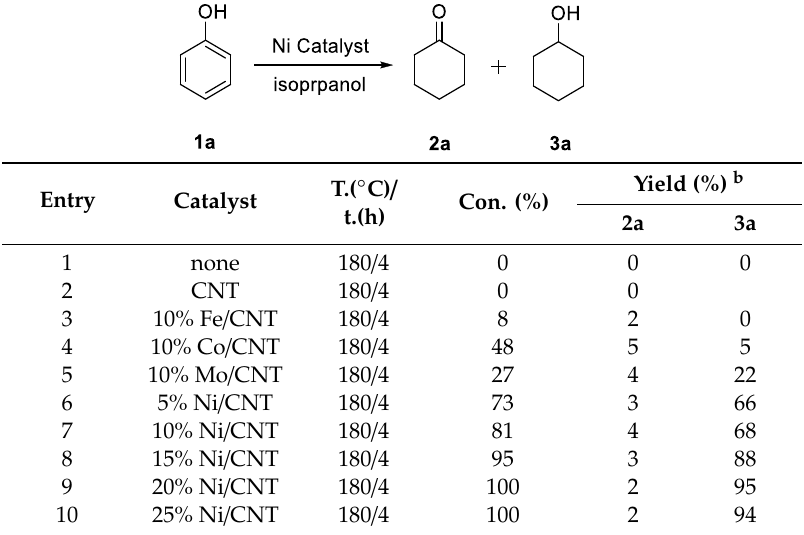
Table 2. Optimization of catalysts for the hydrogenation of phenol a .